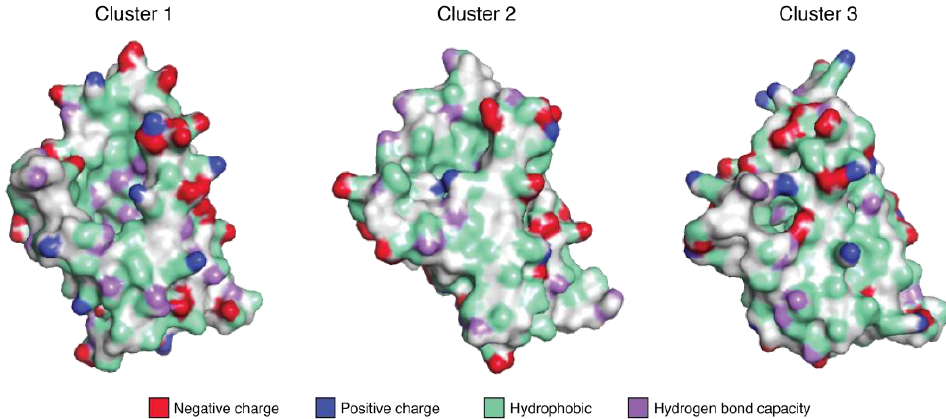
Figure 2. Clustering based on the charge profiles and hydrogen-bond donor/acceptor capacities of the thirteen PR-10 allergens. Cluster 1 comprises the proteins Cor a 1.0401, Cor a 1.0404, Mal d 1.0101, and Pru p 1.0101; Cluster 2 comprises Ara h 8.0101, Act d 8.0101, Bet v 1.0101, Cor a 1.0402, Cor a 1.0403, Pru d 1.0101, Pru p 1.0201, and Pru p 1.0301; Cluster 3 only contains Act c 8.0101. The surfaces are color-coded following the YRB highlighting scheme of Hagemans et al. [25]. The color-coding of positively and negatively charged residues, hydrophobic residues, and residues with hydrogen-bond capacities is specified. All three clusters are shown in the same orientation, with the C-terminal α -helix facing to the front, with its C-terminus pointing down.